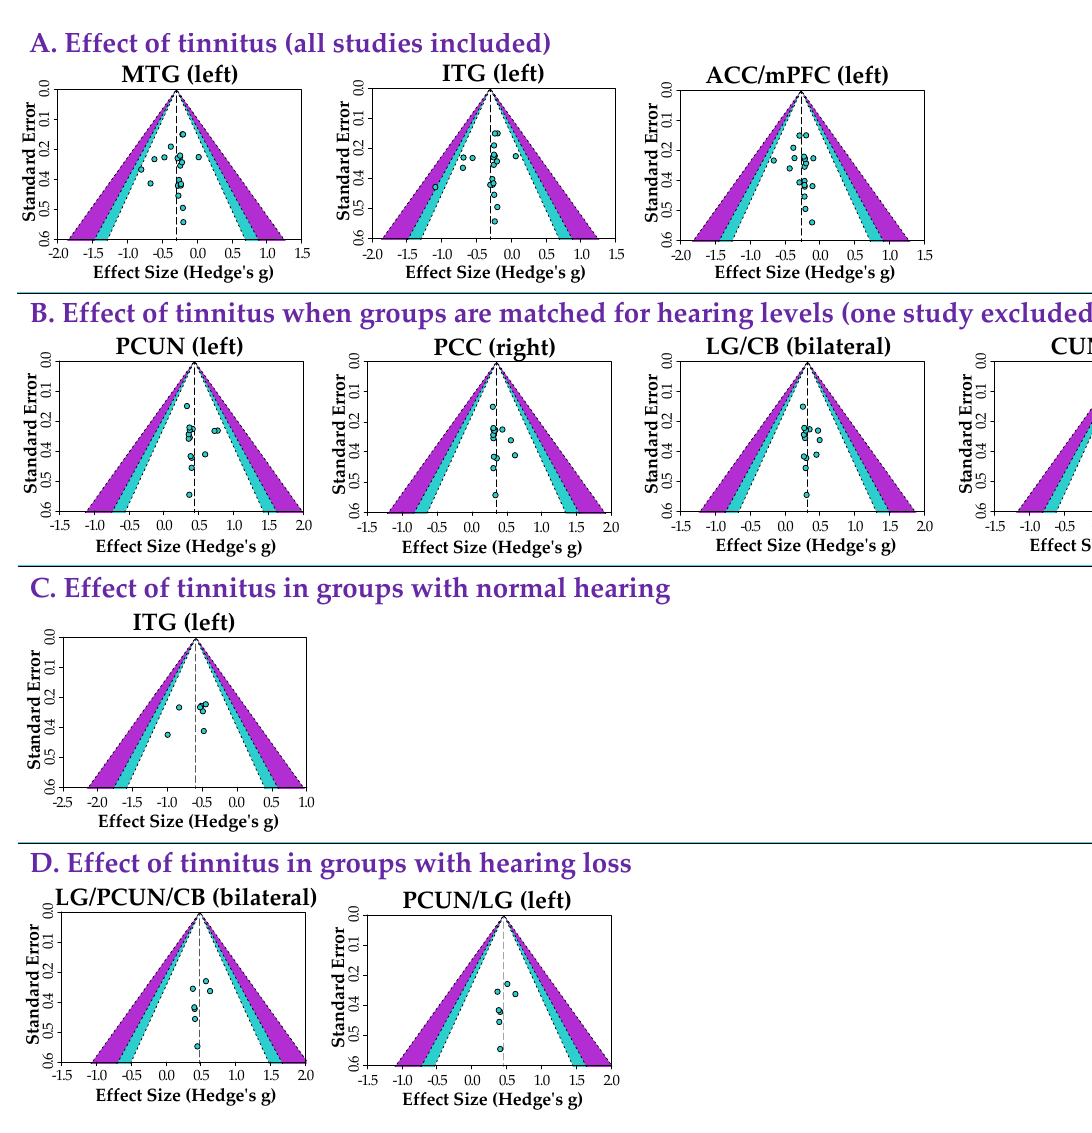
Figure 4. Heterogeneity and publication bias. Funnel plots for every significant finding obtained across the four meta-analyses. None of the funnel plots showed evidence of a reporting publication bias (Egger’s tests: all p > 0.05).